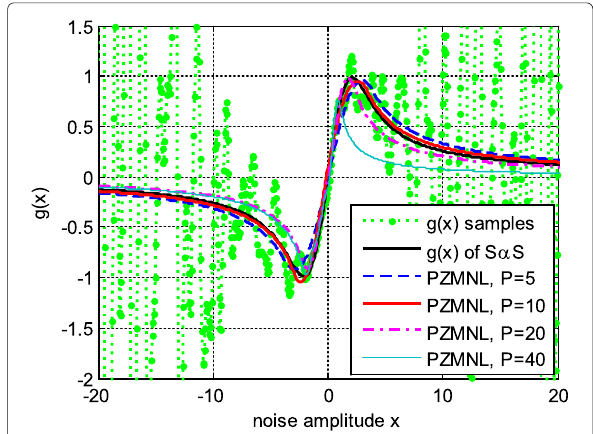
Fig. 5 The PZMNLs in real atmospheric noise for N = 10 4 . g ( x ) of S α S